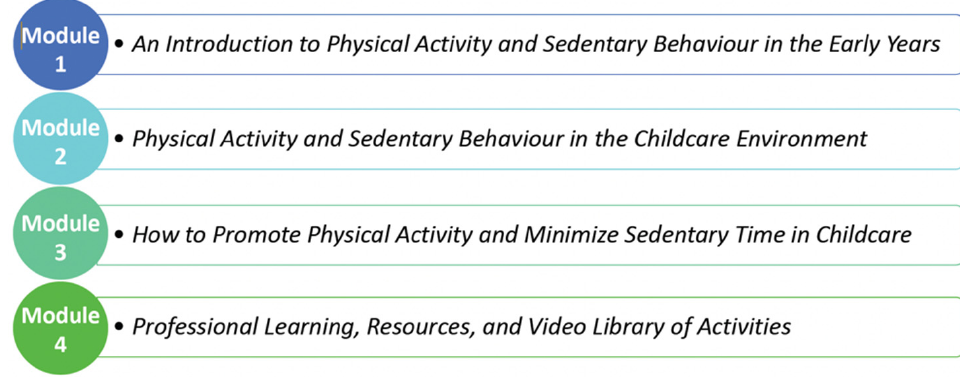
Figure 1. Breakdown of the TEACH study e-Learning course, by module.